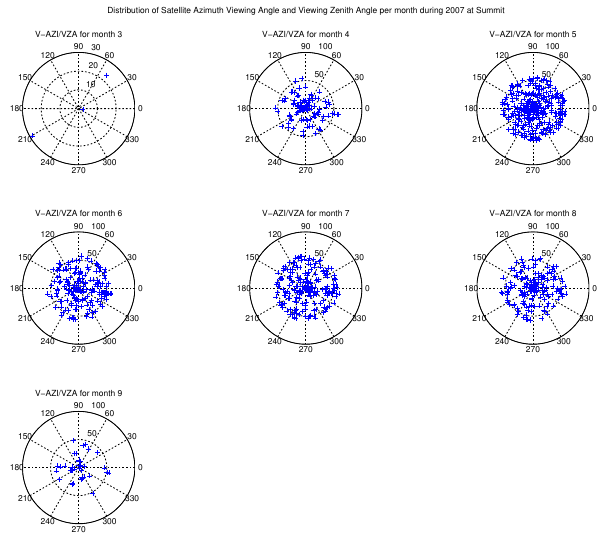
Fig. A2. Sampling of the viewing hemisphere in AVHRR surface reflectance retrievals at Summit camp on the Greenland Ice Sheet during 2007. Radial direction indicates increasing viewing zenith angle; the azimuth direction indicates increasing viewing azimuth angle.